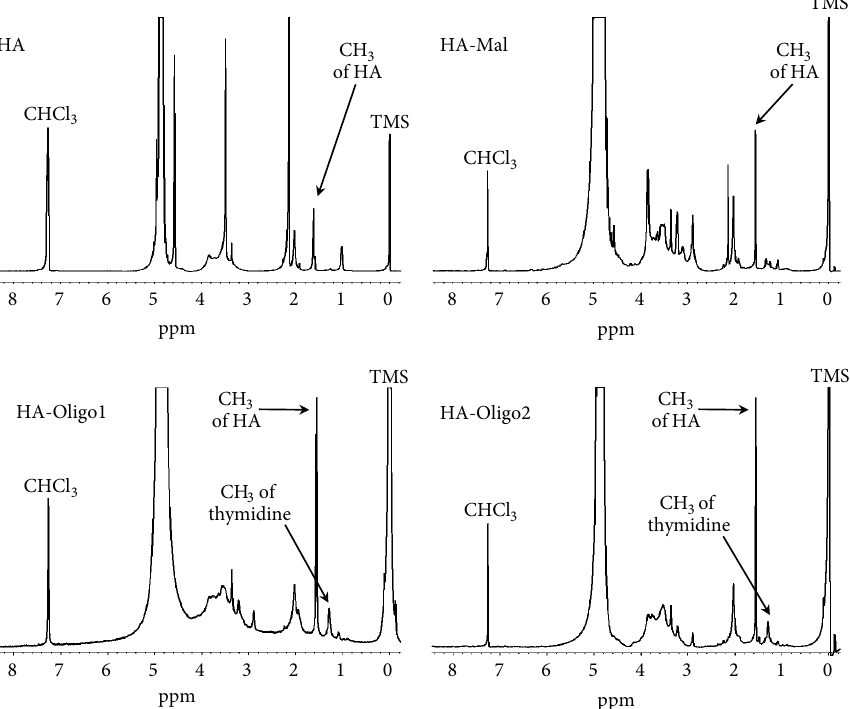
Figure 1: 1 H NMR Spectra of HA, HA-Mal, HA-Oligo1 (HA conjugated with Oligo1), and HA-Oligo2 (HA conjugated with Oligo2). Modification of hyaluronic acid with thiolated oligo